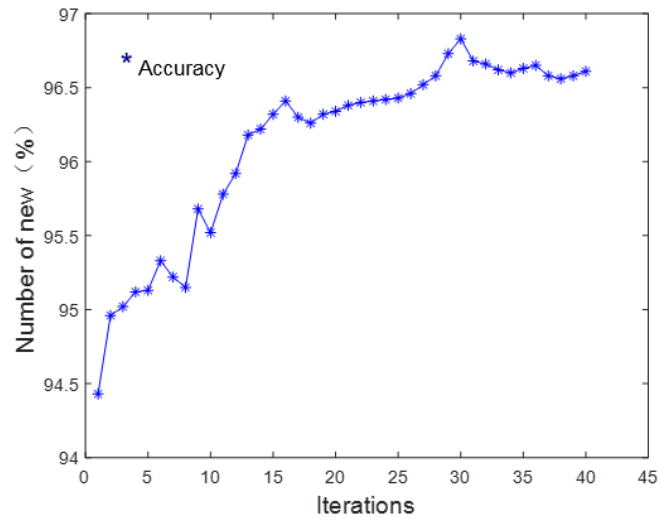
Figure 9. Prediction accuracy versus self-learning iterations.